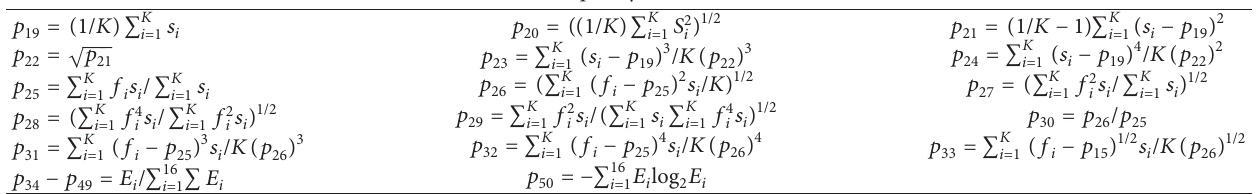
Table 2: Frequency-domain